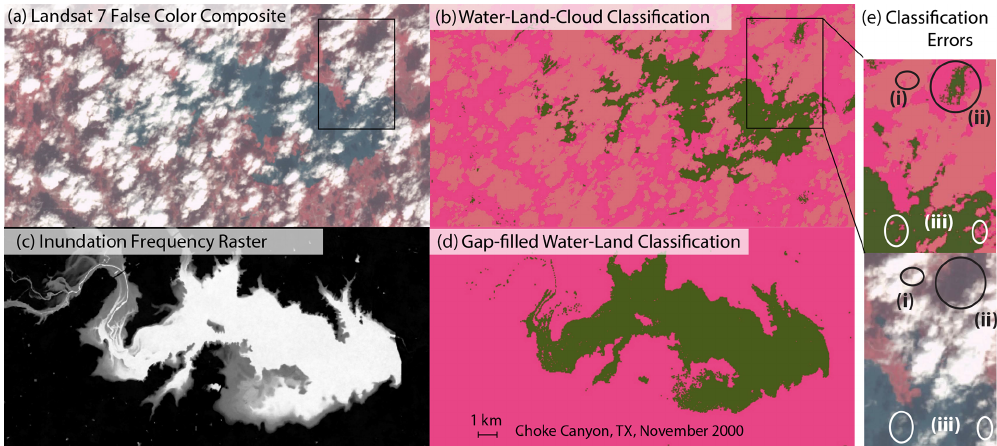
Figure 1. Illustration of the gap-filling algorithm. (a) Original Landsat 7 false color composite image for Choke Canyon, TX, in November 2000. (b) Input-classified ternary image from (Pekel et al., 2016a) with the wet, dry, and masked classes represented in green, dark pink, and light pink, respectively. (c) Inundation frequency image constructed using the 430 monthly ternary images from Pekel et al. (2016a) between March 1984 and December 2019. The IF value is displayed on a linear scale of grays, with values of 0 and 1, respectively, represented as black and white. (d) Output binary image for November 2000, with wet and dry pixels represented in green and dark pink, respectively. (e) Examples of classification errors, as follows: (i) light clouds over land mistakenly classified as clouds, (ii) land-in-cloud shadows mistakenly classified as water, and (iii) light cloud over water mistakenly classified as